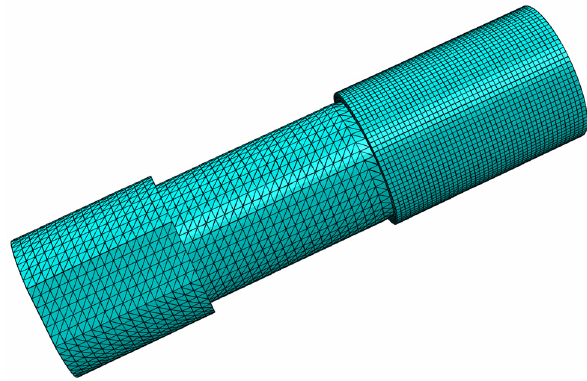
Figure 7: Element size